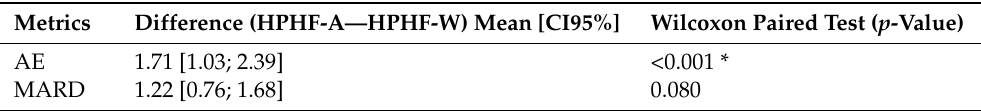
son Mann–Whitney U test between studies for the variable of